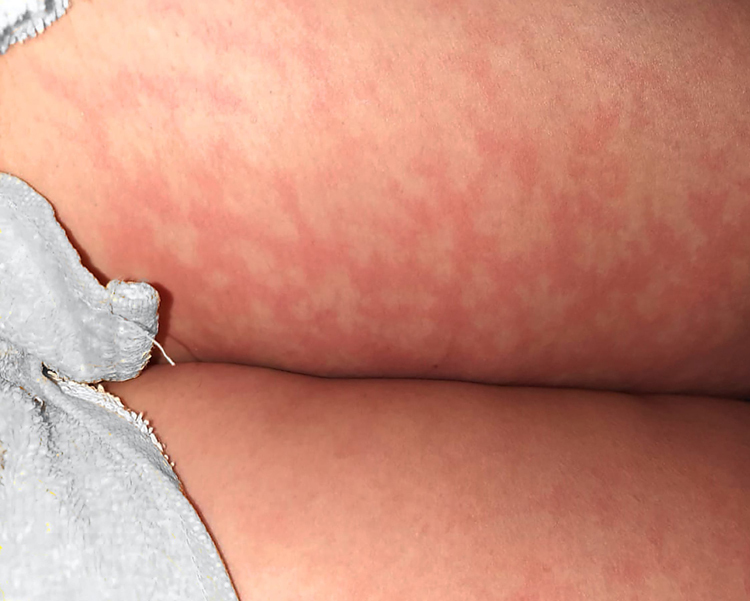
Livedo reticular.